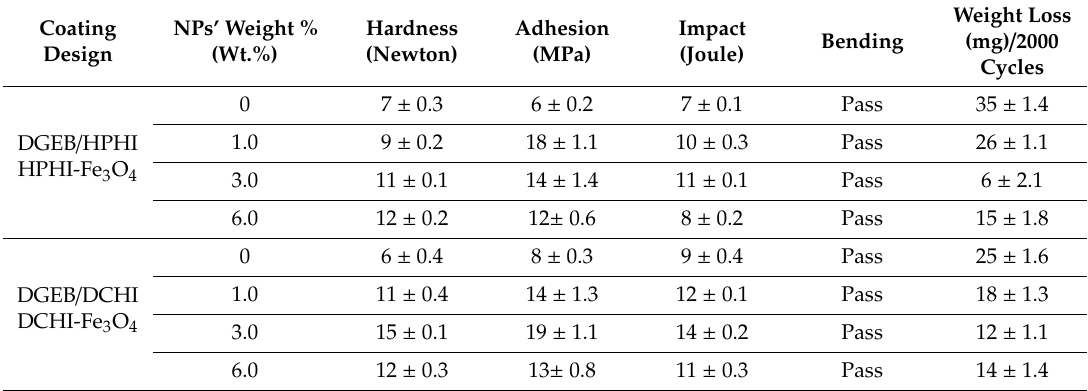
Table 5. Adhesion and mechanical resistance of DGEB / DCHI and DGEB / HPHI coatings systems on the steel substrate in the absence or presence of HPHI-Fe 3 O 4 and DCHI-Fe 3 O 4 NPs.